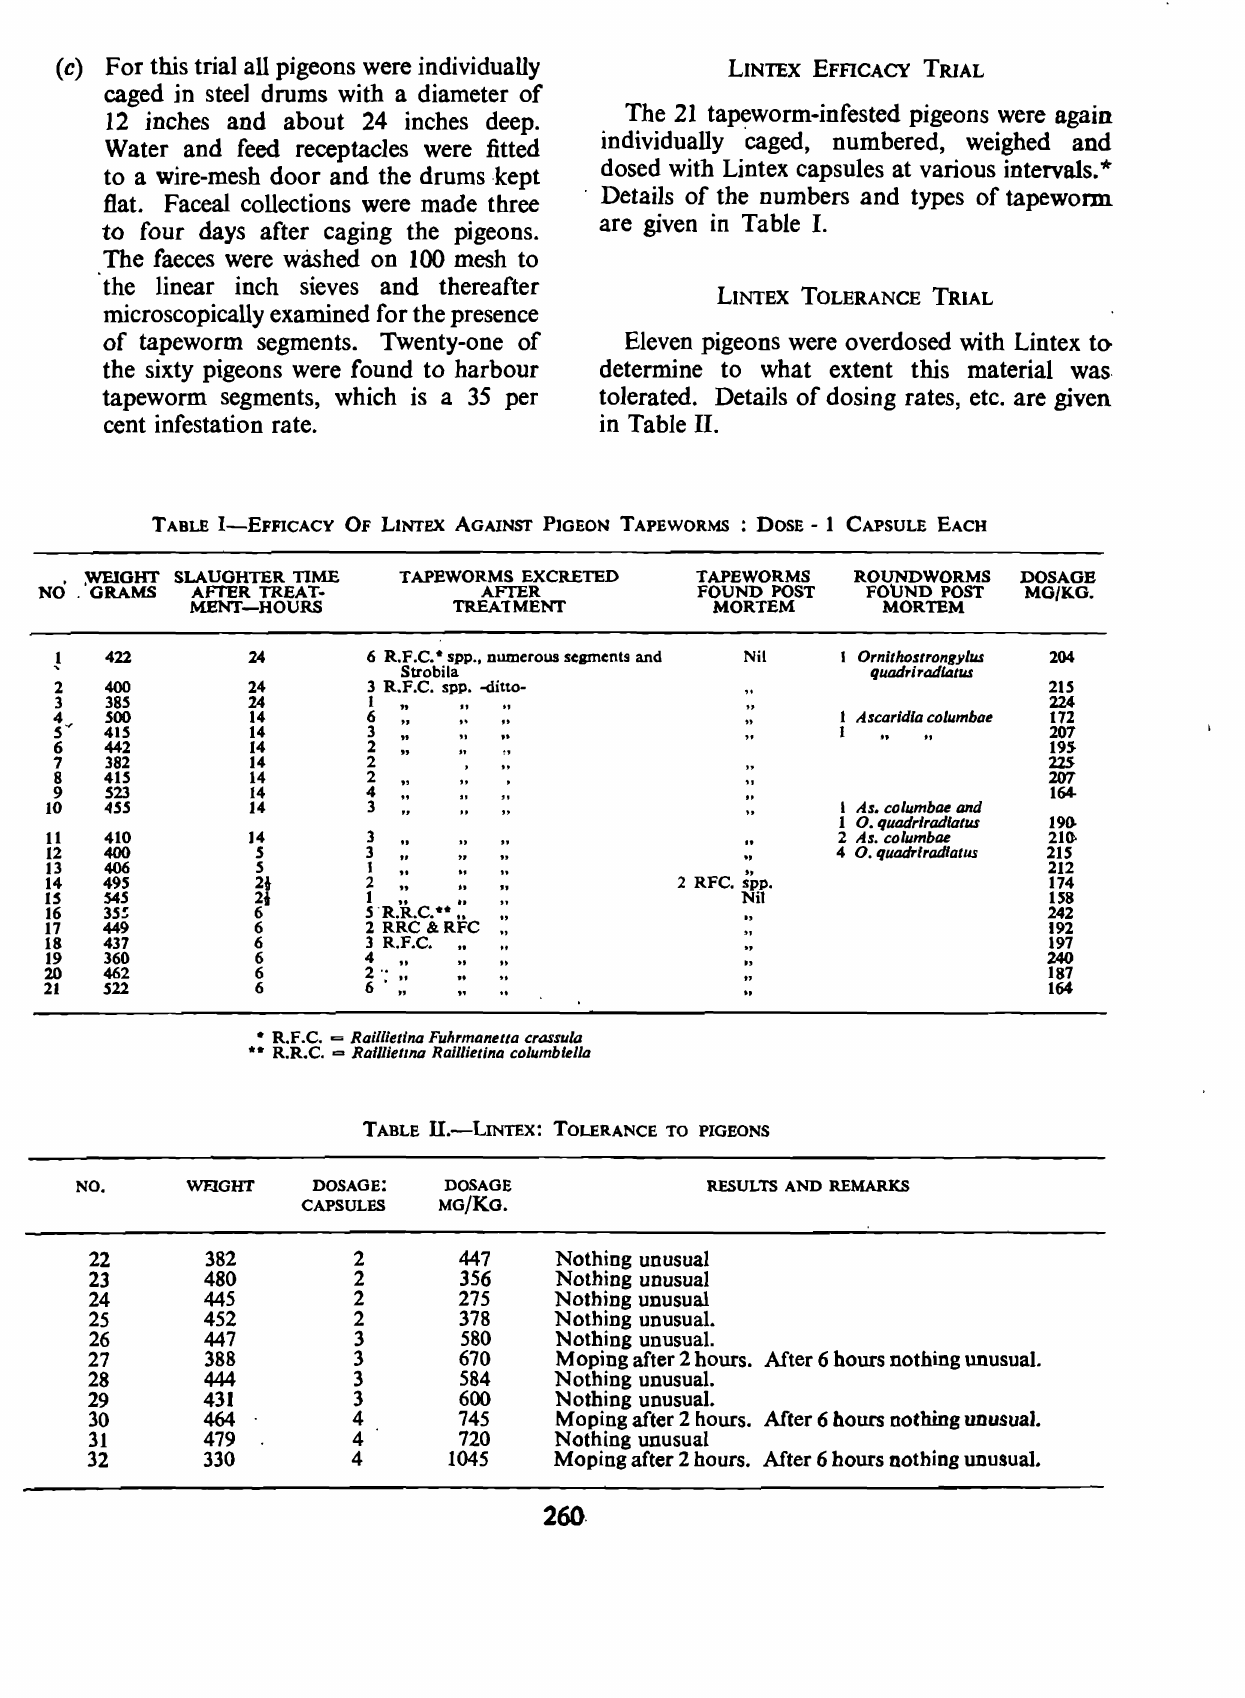
TABLE II.-LINTEx: TOLERANCE TO